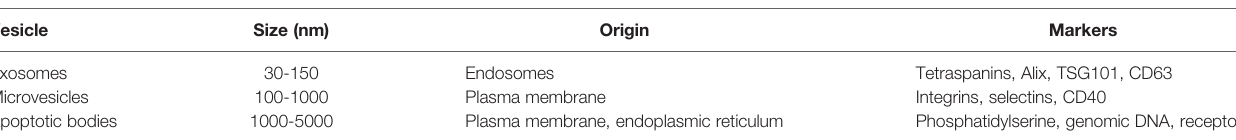
TABLE 2 | Major types of extracellular particles.